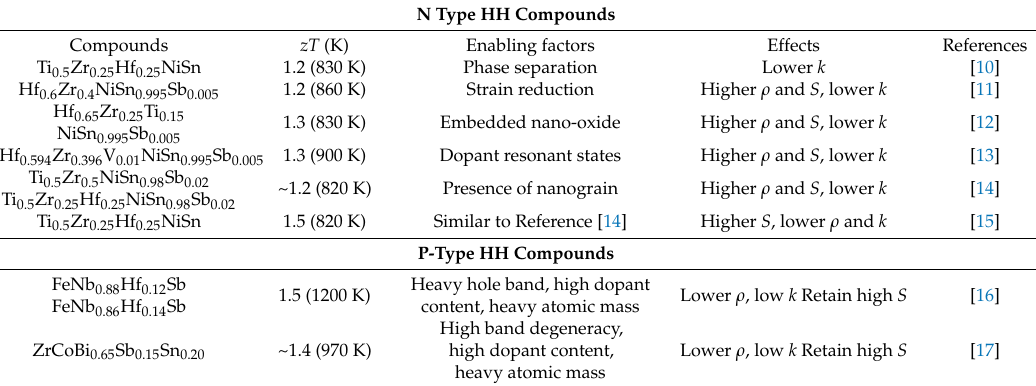
Table 1. Half-Heusler compounds with their highest zT (>1) obtained to date. Included in the table are zT at the indicated temperatures and the enabling factors and effects. Enabling factors may already pre-exist in some compounds but in a less prominent way. Data are from the cited